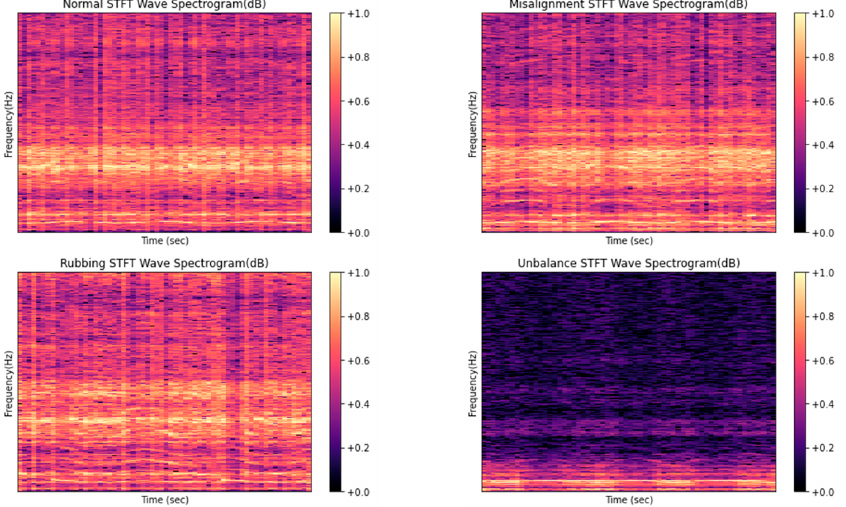
Figure 6. Examples of the changes in STFT spectrograms.